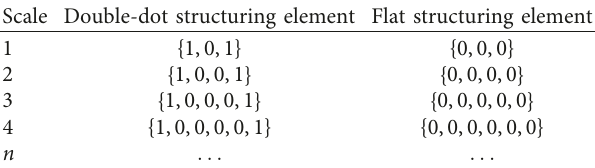
Table 1: Multiscale structuring